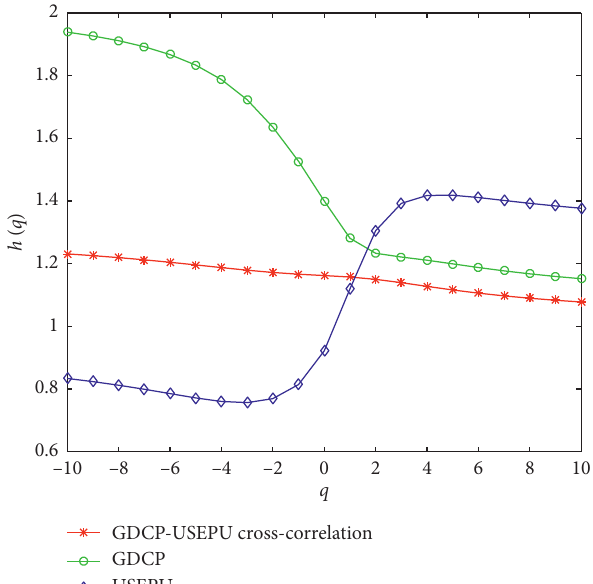
Figure 5: Generalized Hurst exponent of h ( q ) versus q for GDCP and USEPU cross-correlation, the correlation of GDCP, and the correlation of GDCP.